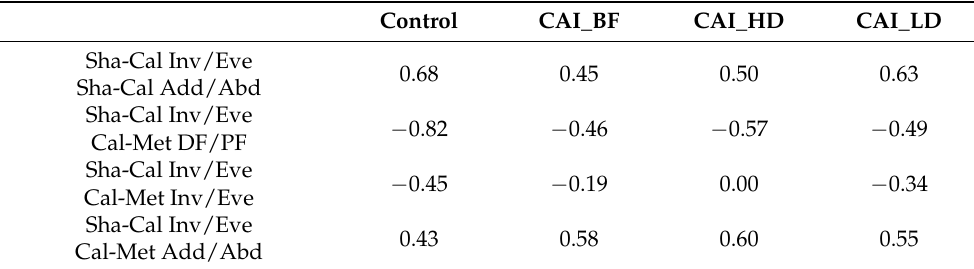
Table 6. Mean cross-correlations for the four participant